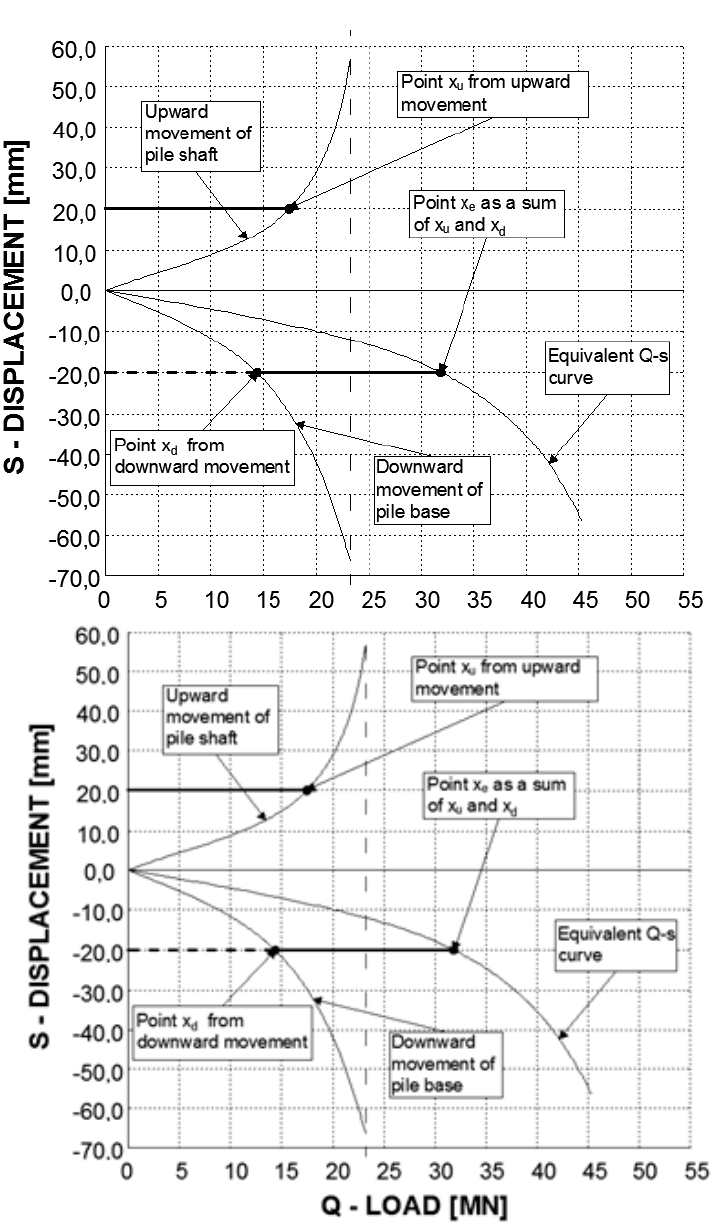
Figure 10. Method for constructing exemplary Q–s curve.